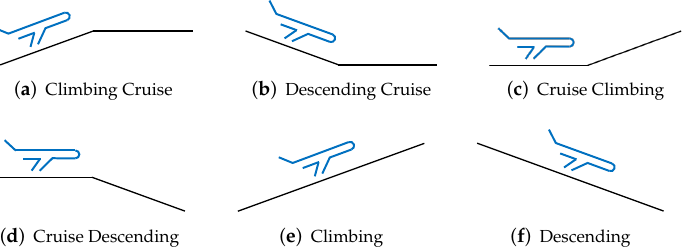
Figure 10. Aircraft altitude evolution that has an interaction with a certain FL.